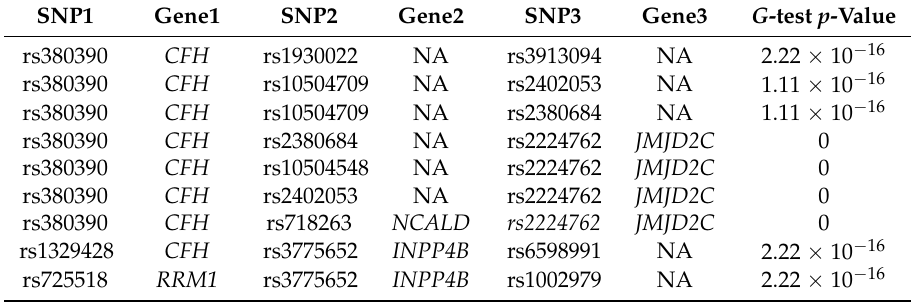
Table 4. Three-way SNP combinations, SNP1, SNP2, and SNP3 were mapped to gene1, gene2, and gene3, respectively. (NA denotes that the corresponding SNP is situated within a non-coding region).